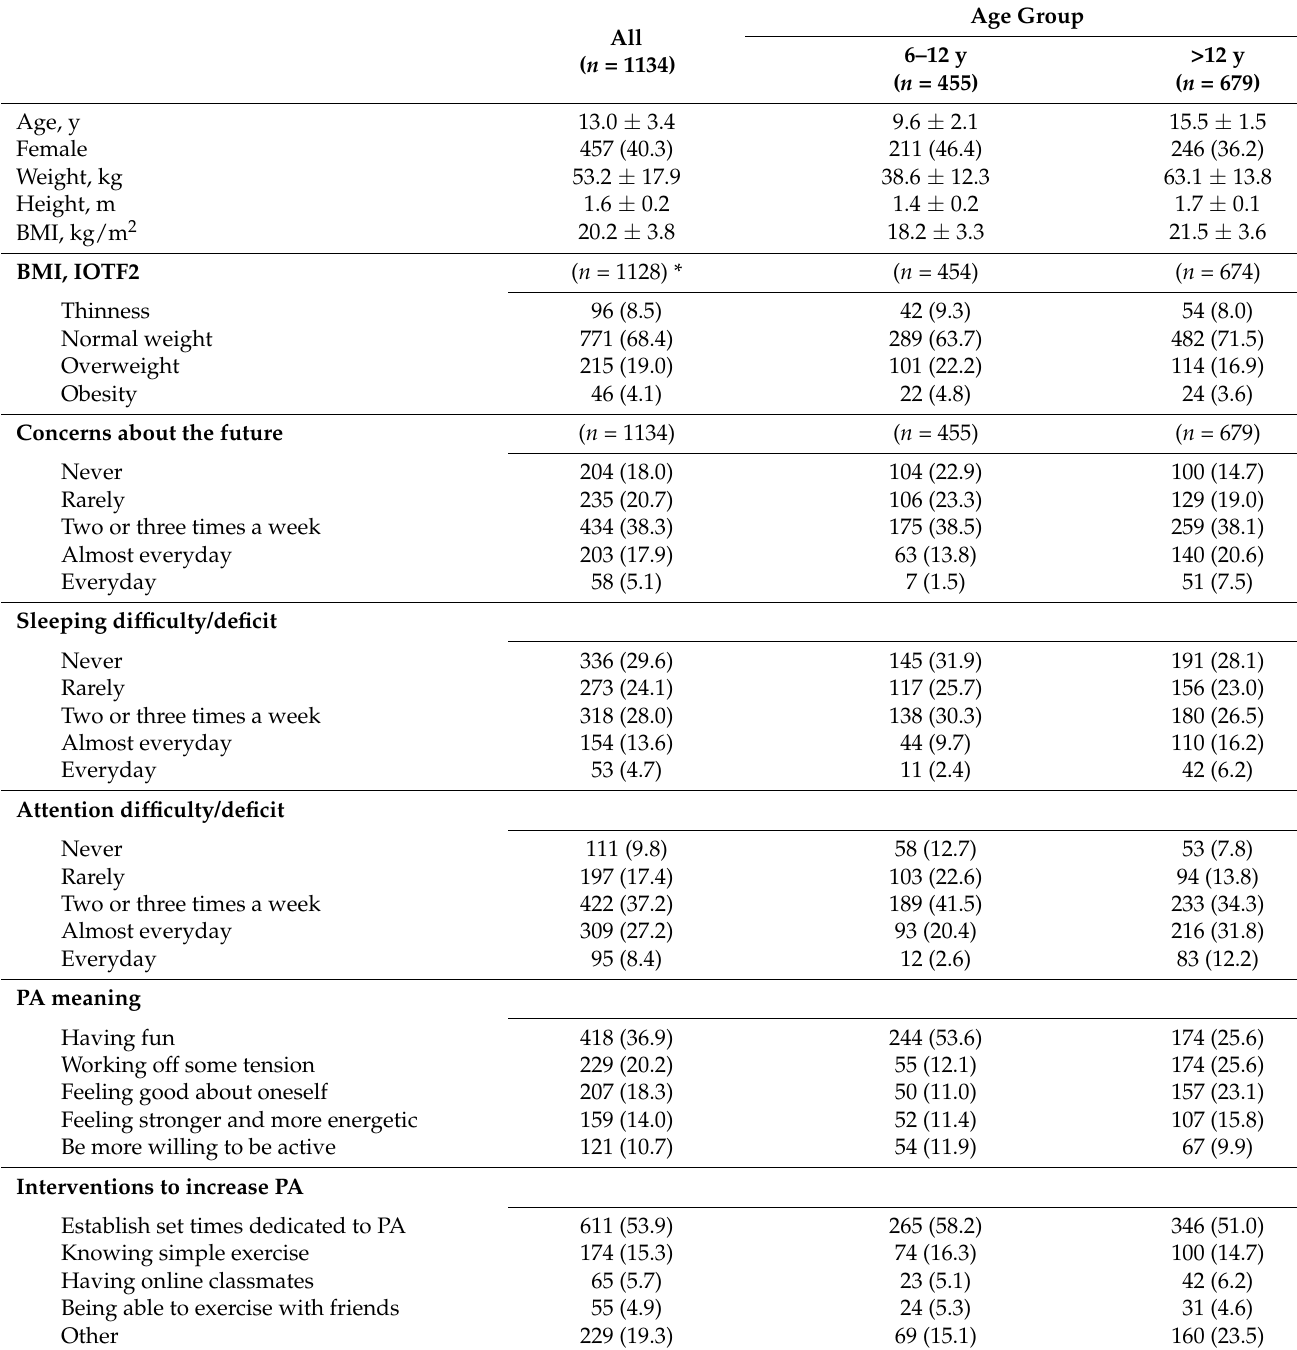
Table 1. Baseline characteristics of the study sample, overall and by age group—Metropolitan City